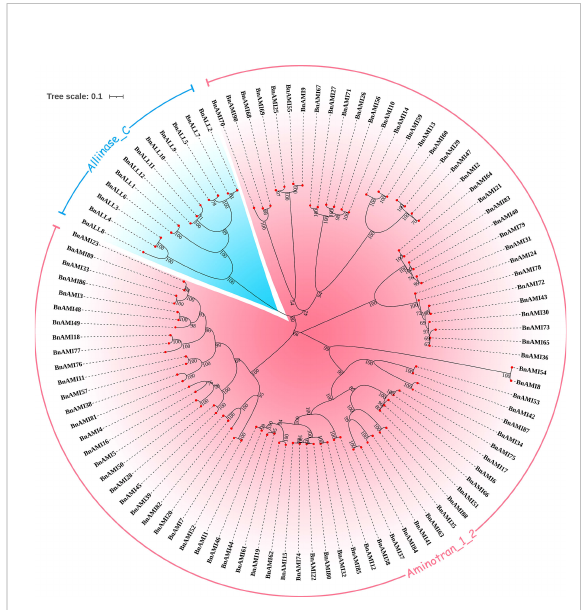
FIGURE 1 Phylogenetic analysis of the BnTAR genes. Different BnTAR gene families were marked in different